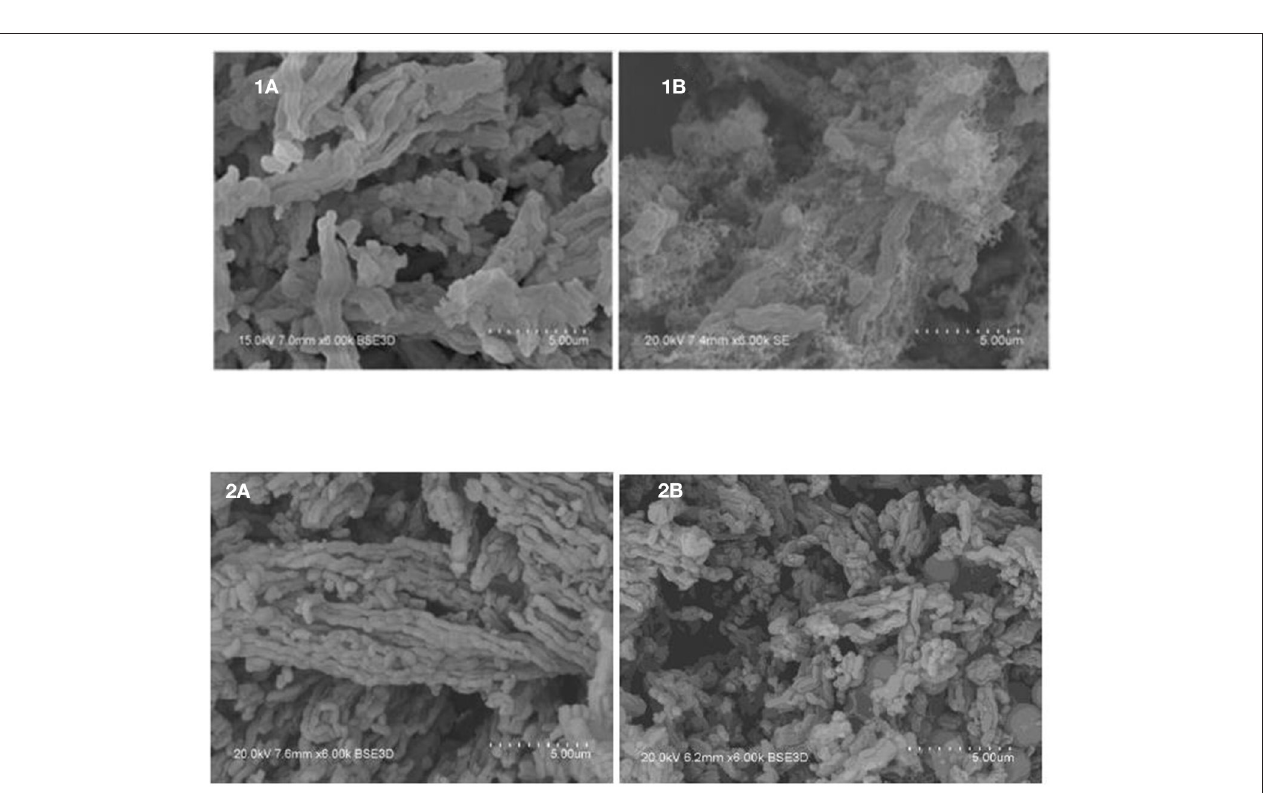
Frontiers in Chemical Engineering |